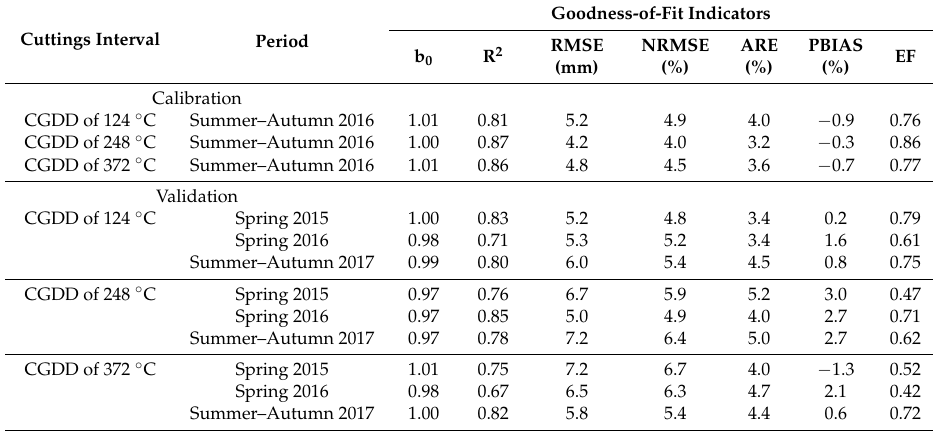
Table 6. Goodness-of-fit indicators relative to both the calibration and validation of all treatments. Cuttings Interval Period